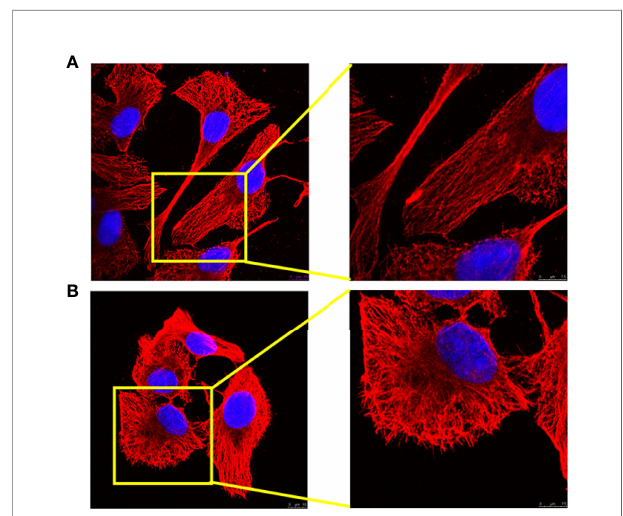
FIGURE 1 | Analysis of 3D4/21-cell morphology under different activation methods. (A) Morphology of (M0) 3D4/21 cells incubated in RPMI-1640 for 24 h. (B) The morphology of (M1) 3D4/21 cells treated with IFN- g /LPS was examined by confocal microscopy. M0-type 3D4/21 cells were a non- polarized control group.